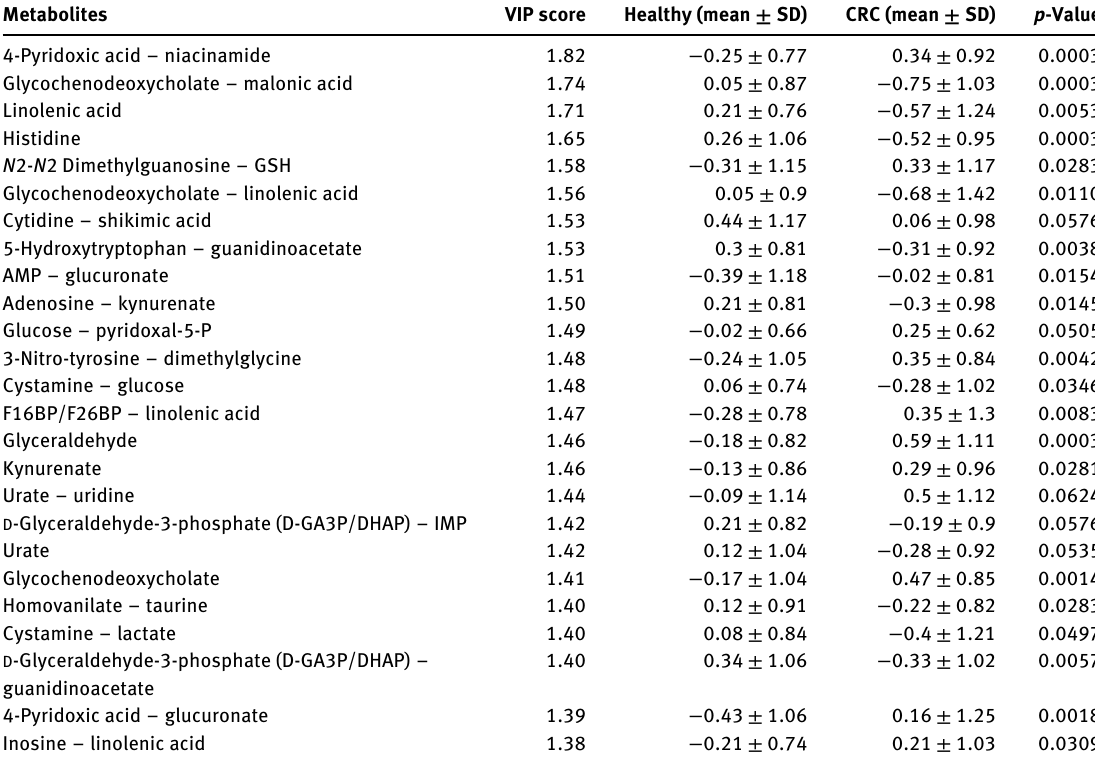
Table 2: Top 25 relevant variable (according to the VIP score) for the PLS-DA model on the enriched dataset between CRC and healthy